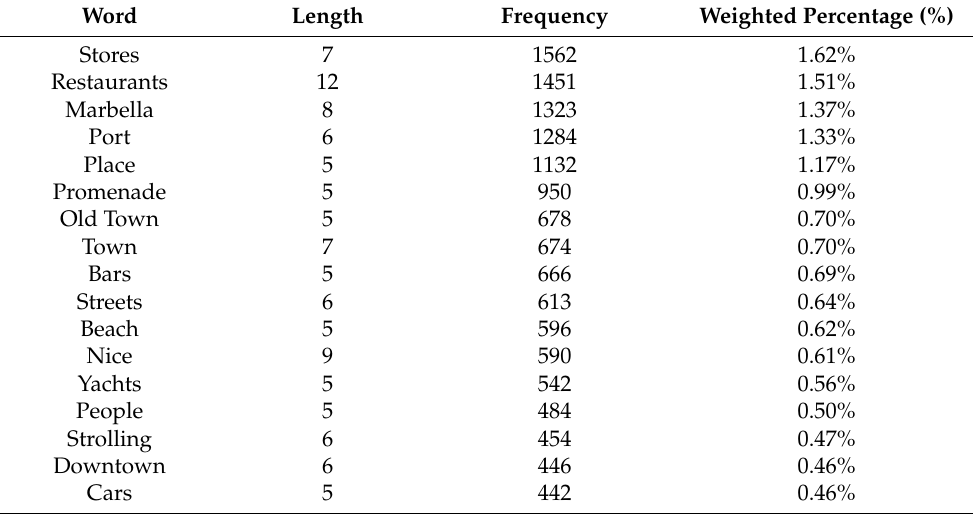
Table 5. Commenters’ most frequently used